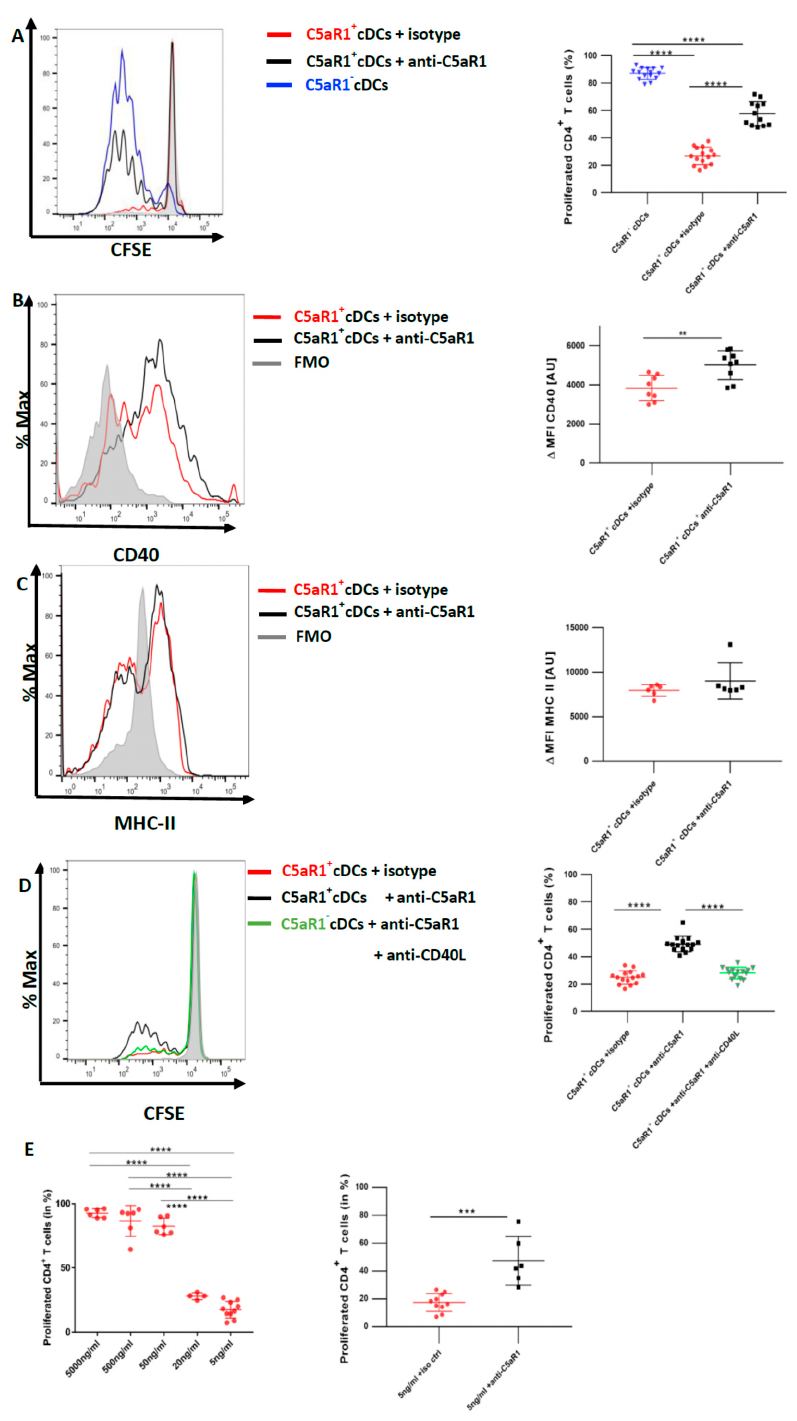
Figure 6. In vitro targeting of C5aR1 strongly enhances the potency of C5aR1 + cDCs to promote CD4 +